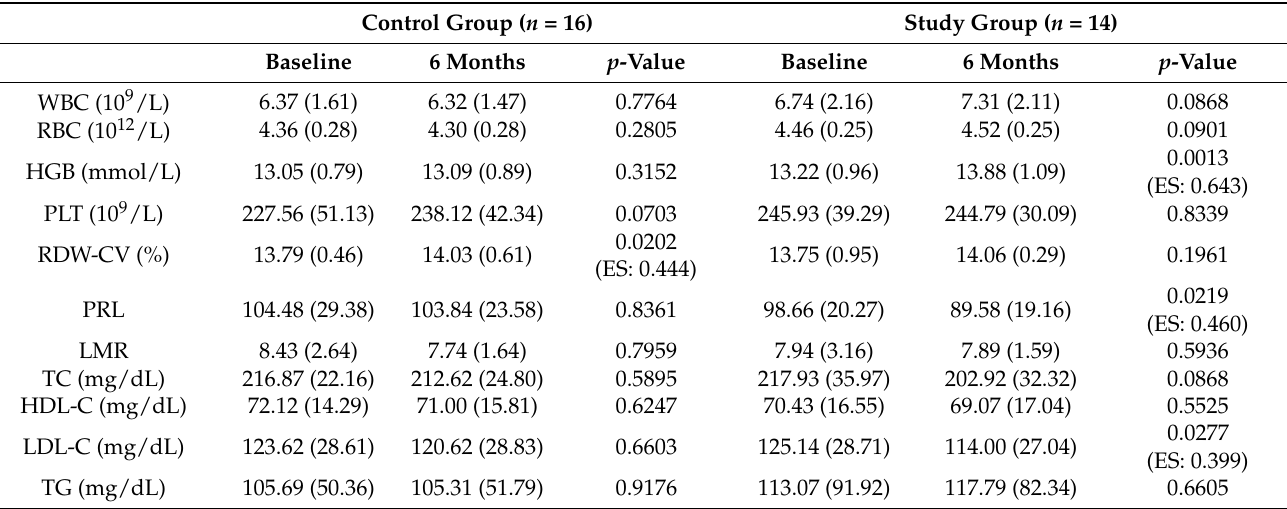
Table 2. Haematological parameters and lipid profile of women in the control and study groups on the first and second testing